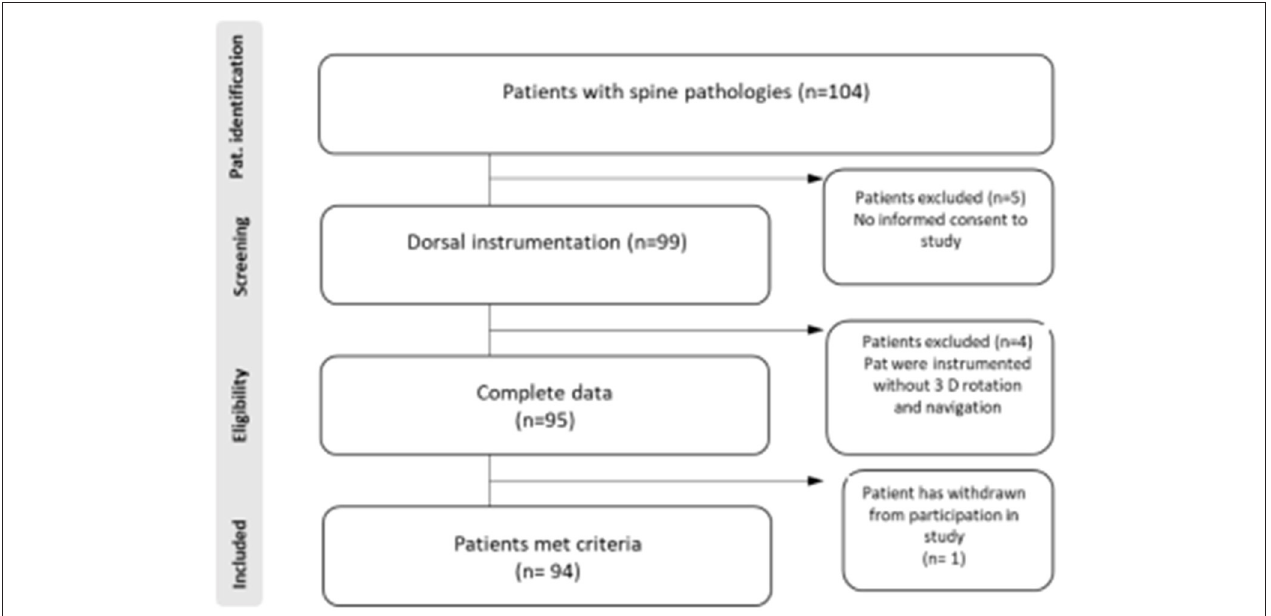
FIGURE 1 | Flowchart of patient inclusion